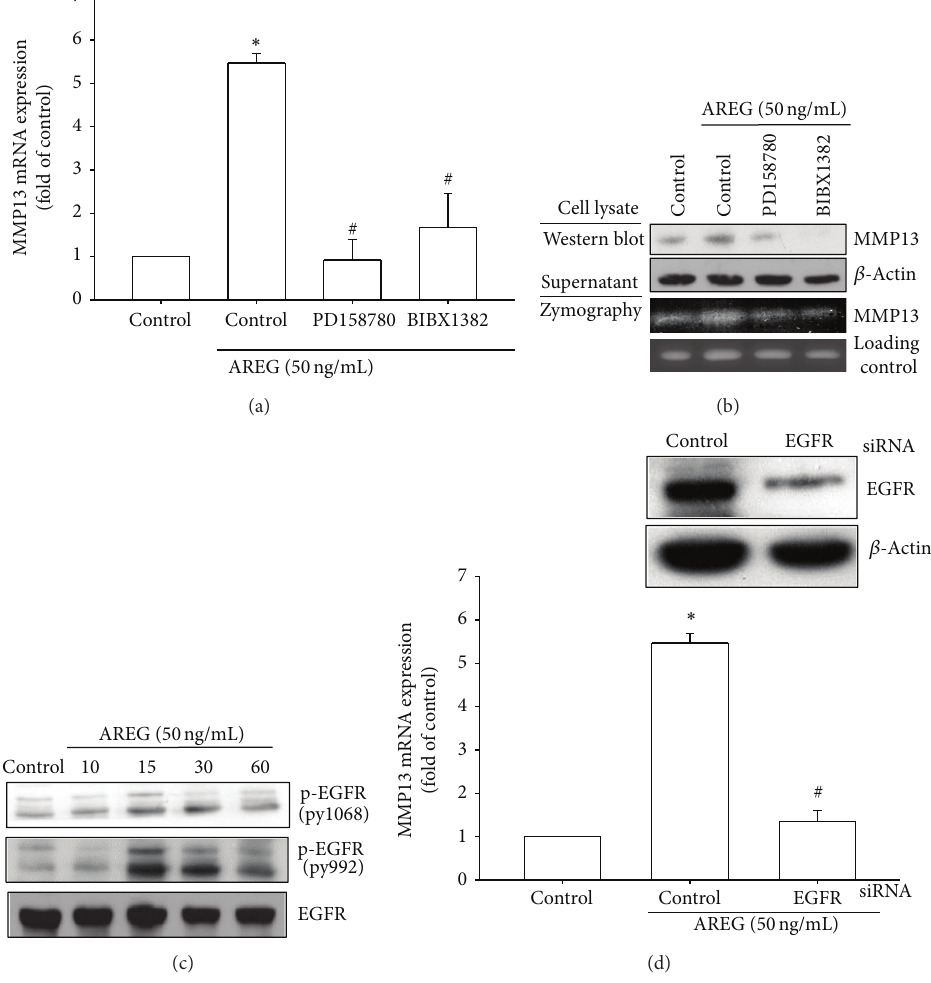
Figure 2: EGFR is involved in AREG-mediated MMP-13 production in synovial fibroblast. (a) OASFs were pretreated for 30 min with PD158780 (1 𝜇 M) and BIBX1382 (1 𝜇 M) followed by stimulation with AREG for 24 h, and MMP-13 expression was examined by qPCR. (b) OASFs were pretreated for 30 min with PD158780 (1 𝜇 M) and BIBX1382 (1 𝜇 M) followed by stimulation with AREG for 24 h, and MMP- 13 protein levels in cell lysates were determined by Western blot analysis. MMP-13 enzymatic activity in cell lysates and supernatants was measured using zymography. (c) OASFs were incubated with AREG for indicated time intervals, and EGFR phosphorylation was examined by Western blot. (d) OASFs were transfected for 24h with EGFR siRNA, followed by stimulation with AREG for 24 h, and MMP-13 expression was examined by qPCR. Results are expressed as the mean ± SEM (𝑛 = 3) . ∗ 𝑃 < 0.05 compared with control; # 𝑃 < 0.05 compared with AREG- treated